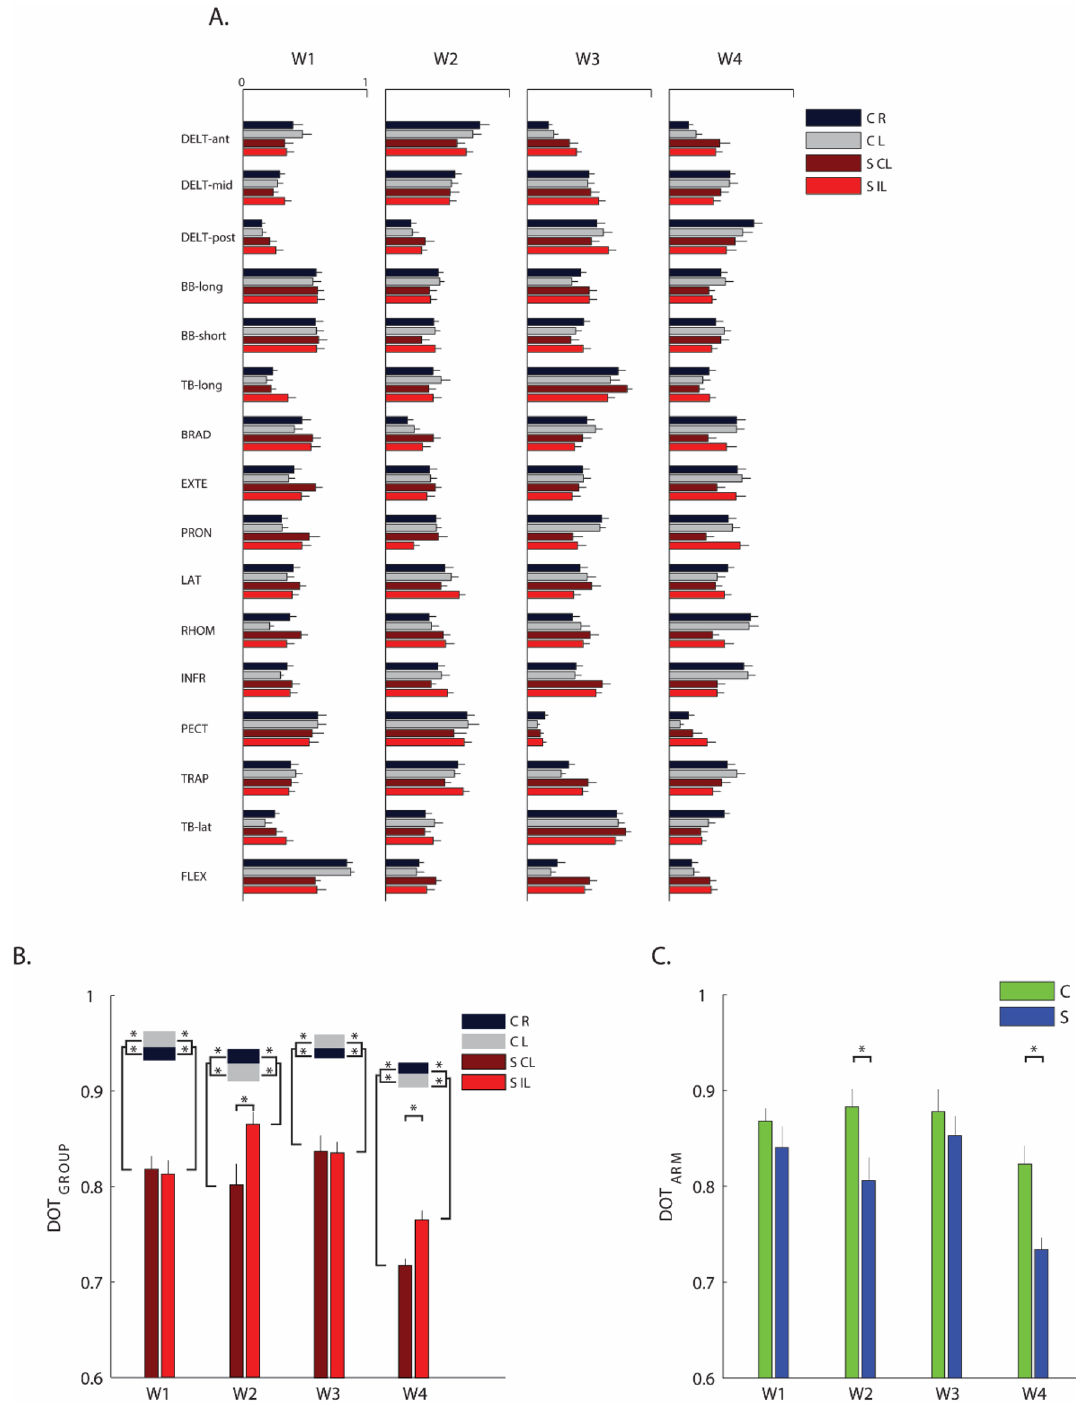
Figure 5. Weight coefficients of the muscle synergies. ( A ) Weight coefficients for the four muscle synergies (W1 to W4). Weight coefficients were computed considering all trials, i.e., including all directions and repetitions. Control subjects (C) and stroke subjects (S) are shown with different colors as indicated in the legend. Darker and brighter colors represent the right (R) and left (L) arm respectively for the control subjects and contralesional (CL) and ipsilesional (IL) arm in the stroke subjects. The error bars represent the standard error. ( B ) Comparison between groups (i.e., between stroke and control subjects) by the scalar product of weight coefficients of each muscle synergies (DOT INTER-GROUP ). For the weight coefficient of each synergy, W1 to W4, darker and lighter red bars indicate the values obtained by comparing respectively the contralesional (CL) and ipsilesional (IL) arm of each stroke subject with the corresponding arm of his/her control subject, then averaging across the stroke group. The grey and black horizontal bars indicate the values obtained by comparing respectively the weight coefficients of the muscle synergies for the left (L) and the right (R) arm of one control subject with the corresponding arm of all the other controls, and then averaging across the control group (DOT INTRA-GROUP ). The error bars correspond to the standard error. ( C ) Comparison between the two arms of a same subject by the scalar product of weight coefficients of the muscle synergies (DOT ARM ). For the weight vector of each synergy, W1 to W4, blue and green bars indicated the values obtained by comparing the two arms of stroke subjects and controls, respectively. The error bars correspond to the standard error. ( B , C ): * indicates significant differences (p < 0.05) between stroke and control